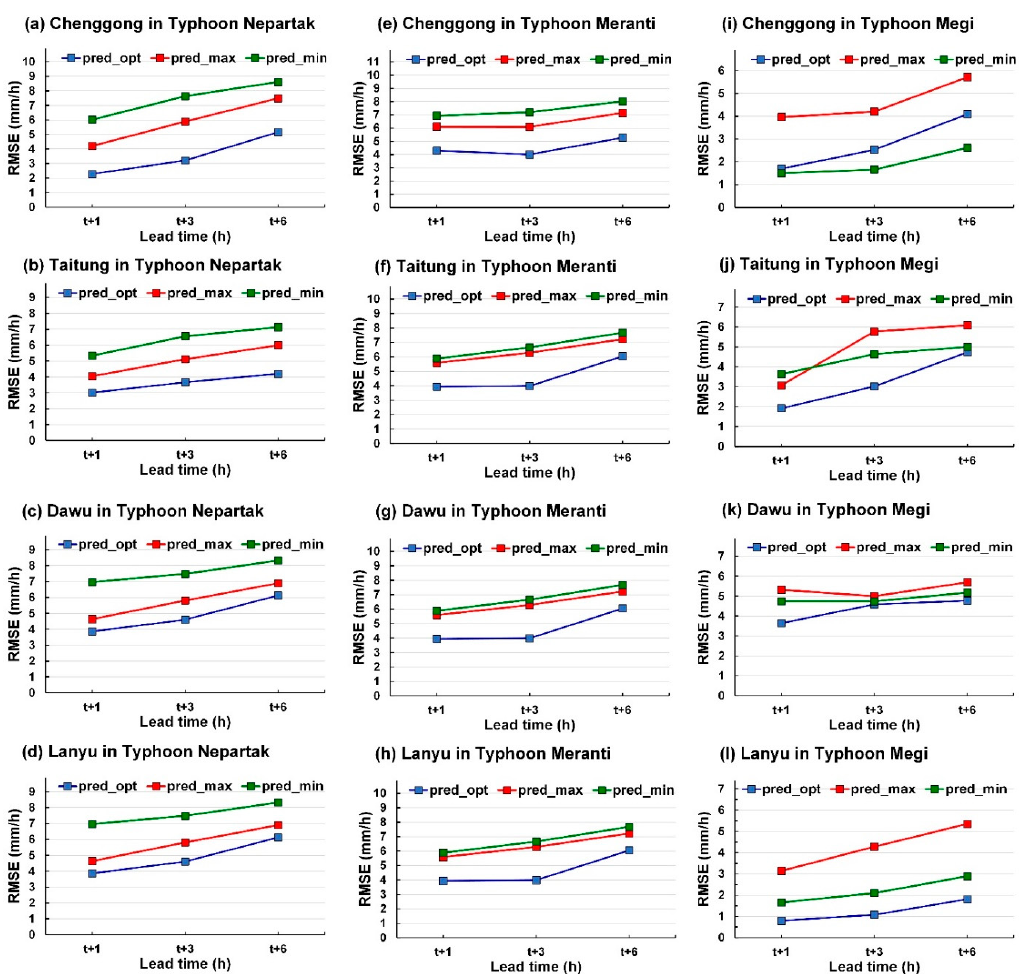
Figure 11. RMSE results for pred_opt, pred_max, and pred_min for each typhoon and station: ( a – d ) Typhoon Nepartak; ( e – h ) Typhoon Meranti; ( i – l ) Typhoon Megi.